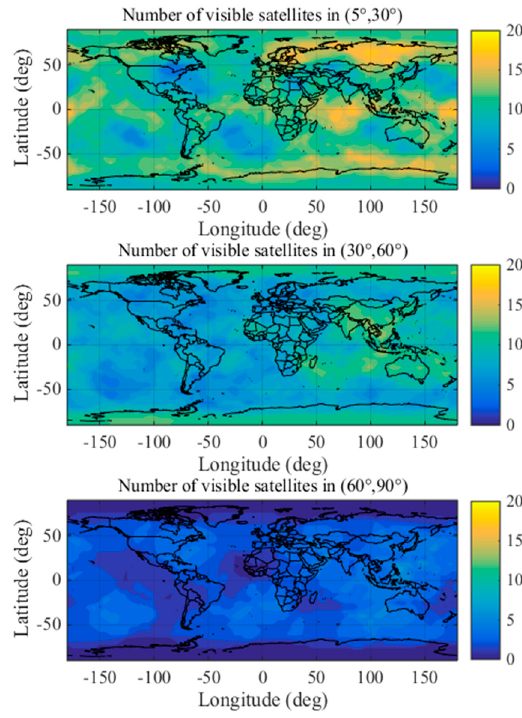
Figure 15. The number of visible satellites in different elevation ranges.